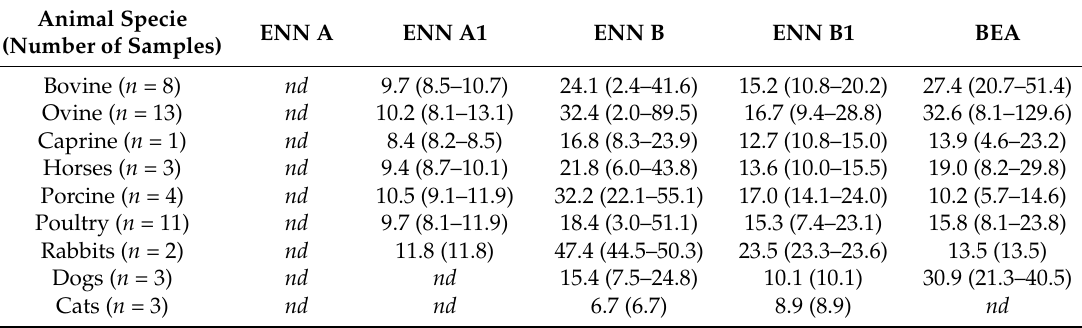
Table 4. The Enniatin and Beauvericin Contents in the feed samples analyzed ( n = 48). The results are expressed as an average (concentration range) in µ